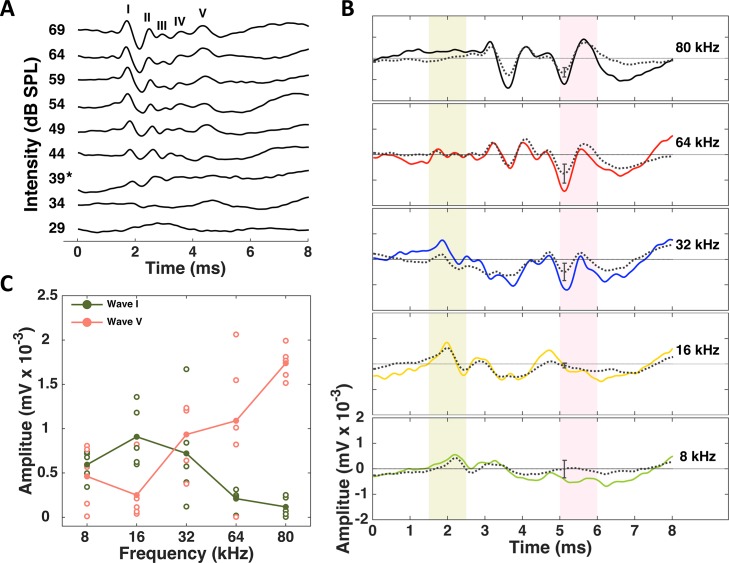
Auditory brainstem responses to click and tone stimuli.(A) ABRs recorded from one CBA/CaJ mouse in response to clicks of increasing intensity (individual traces from bottom to top). The star on the y-axis represents the threshold stimulus intensity. The different ABR peaks are labeled using roman numerals. (B) ABRs recorded from one CBA/CaJ mouse in response to pure-tone pips of increasing frequency (individual panels from bottom to top). Each panel shows the mean response (in color) averaged over 500 repeats. The black stippled line in each panel shows the mean response (± standard error) averaged over a population of 5 animals. The shaded areas in light green and pink indicate the timing of waves I and V respectively. (C) Amplitude of wave I vs. wave V at each of the frequencies we tested. Open circles represent the data obtained from individual animals. The lines join the mean values across different frequencies.